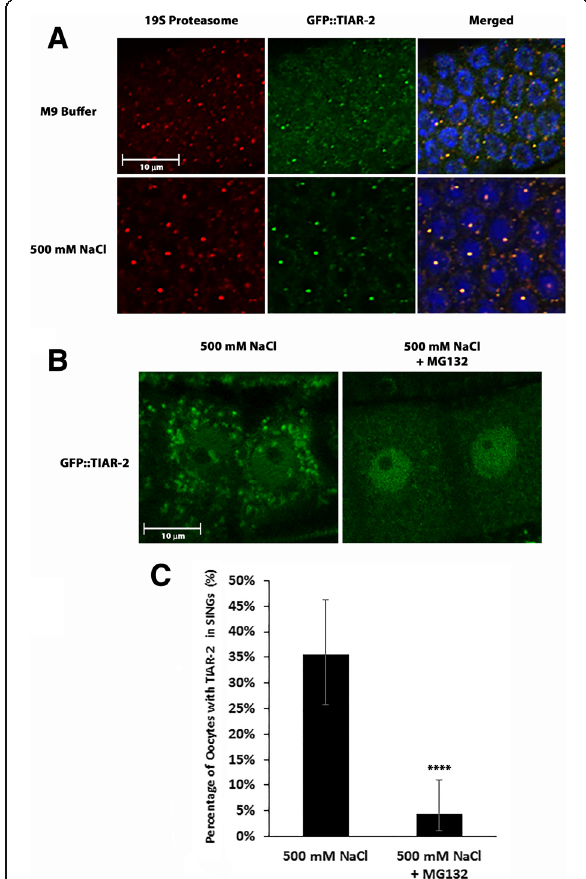
Fig. 9 SINGs contain the TIAR-2 protein. a Worms expressing GFP::TIAR-2 were soaked in M9 or 500 mM NaCl for 60 min and then stained with an antibody to the 19S proteasome. The merged image shows the TIAR-2, proteasome, and DAPI channels. In M9 treated worms, few oocytes showed nuclei with TIAR-2 and proteasome colocalization (38/600). Whereas, in salt stressed worms, the number of TIAR-2 and proteasome colocalization events increased (212/600 oocytes). Data were collected from 3 independent experiments ( n = 30 worms). Scale bar indicates 10 μ m. b Day 4 adults